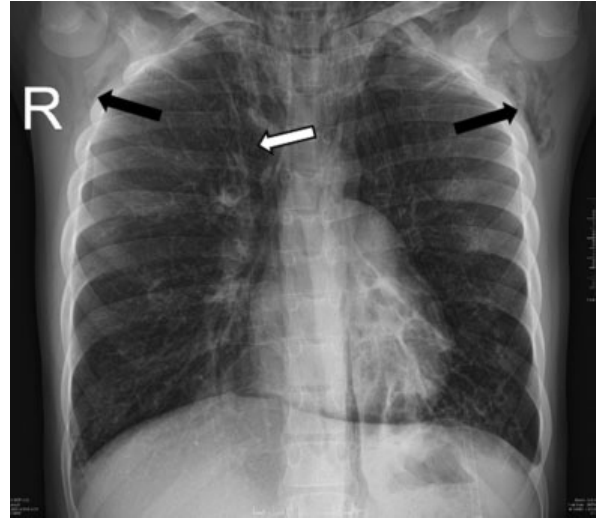
Fig. 1 Chest X-ray, taken at the time of admission, also shows pneumomediastinum (white arrow); the subcutaneous emphysema is also visible (black